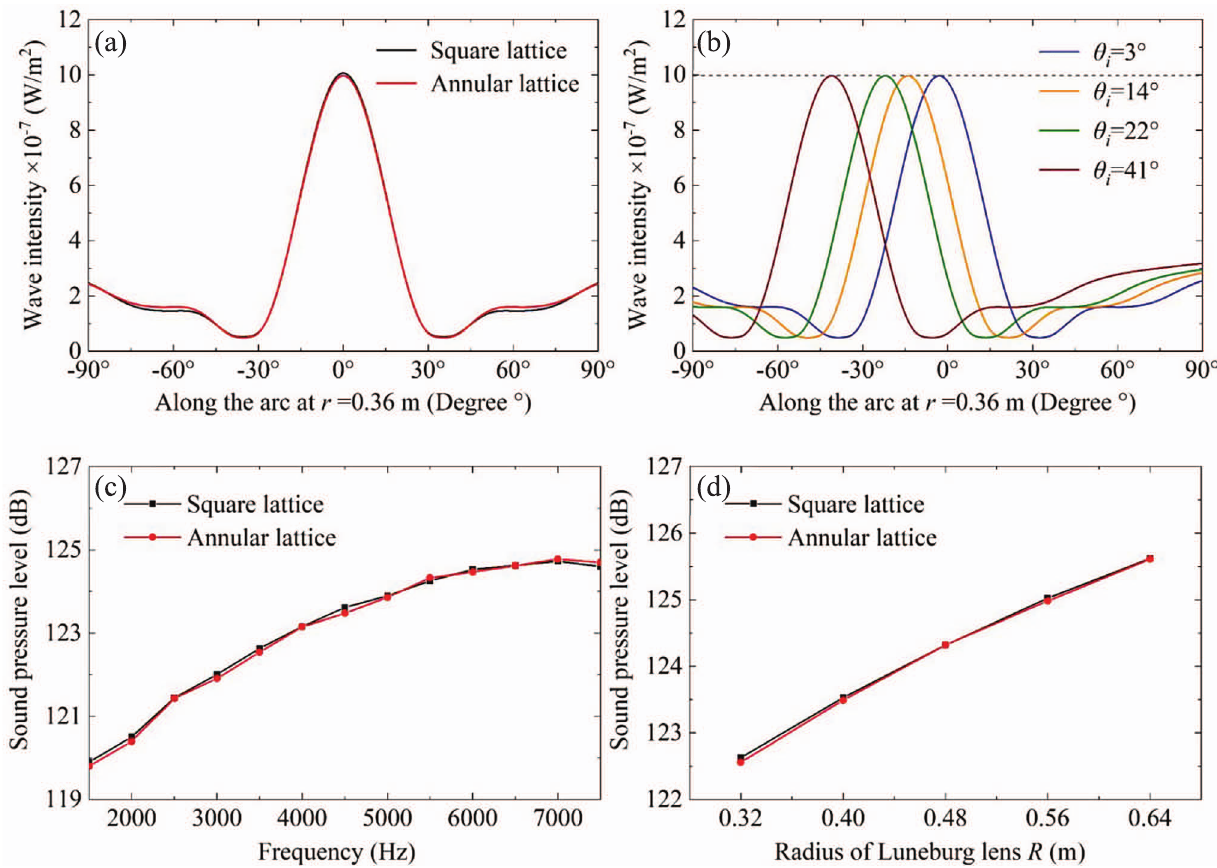
respectively. (c) Sound pressure level as a function of frequency. (d) Sound pressure level with the radius of Luneburg lens increased.